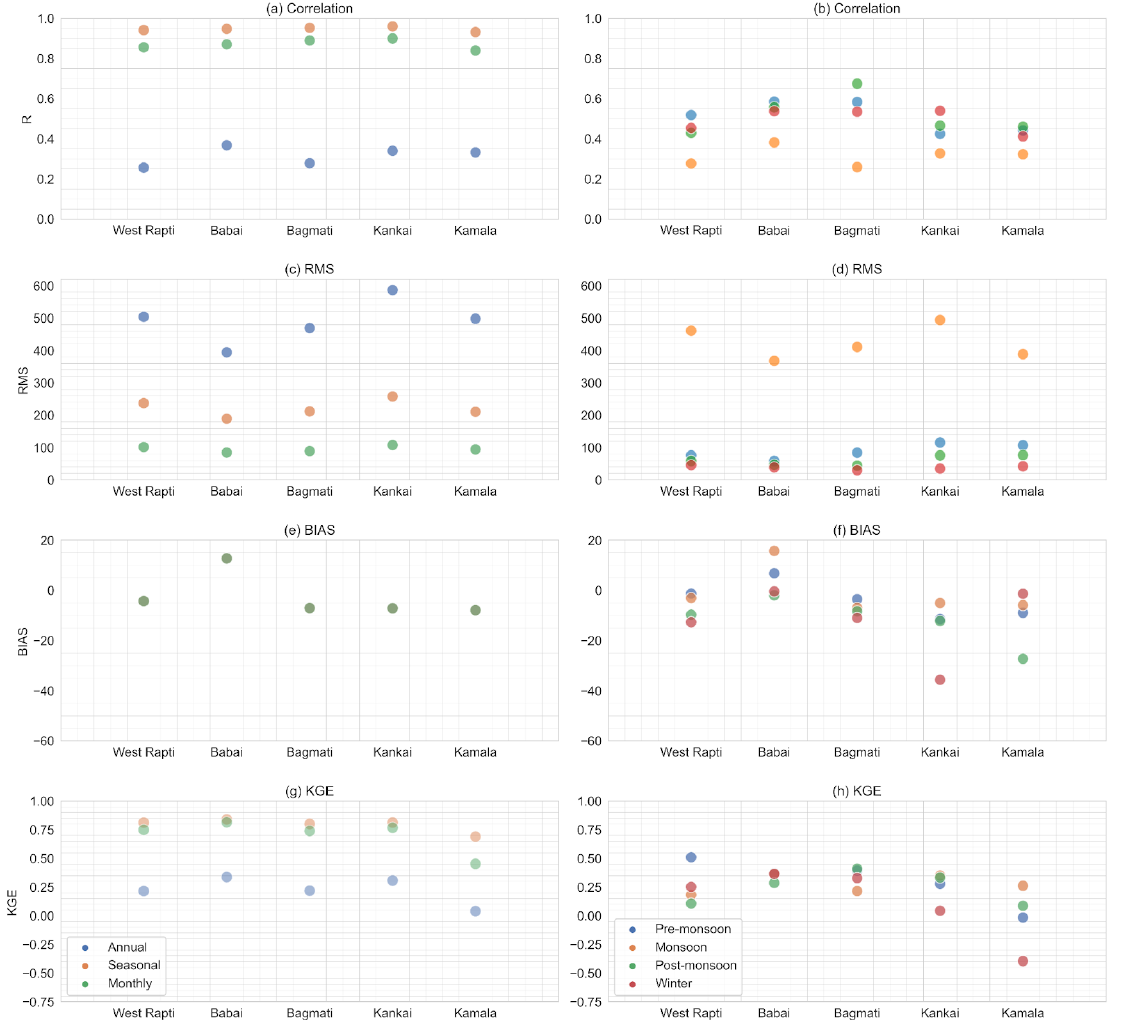
Figure 3. Scatter plots of R, RMS, BIAS, and KGE for different time scales ( a , c , e , g ) and different seasons ( b , d , f , h ) for rainfall from CHIRPS versus rain gauge observations during 1986–2015.